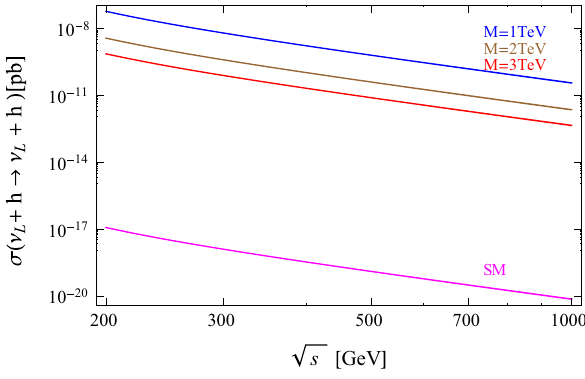
Fig. 4 The total cross section for ν L h → ν L h scattering as a function of the neutrino–Higgs center-of-mass energy 3 TeV at c 3 / 2 = 1. Cases with c 3 / 2 (cid:8)= 1 can be reached via the rescaling M → M /